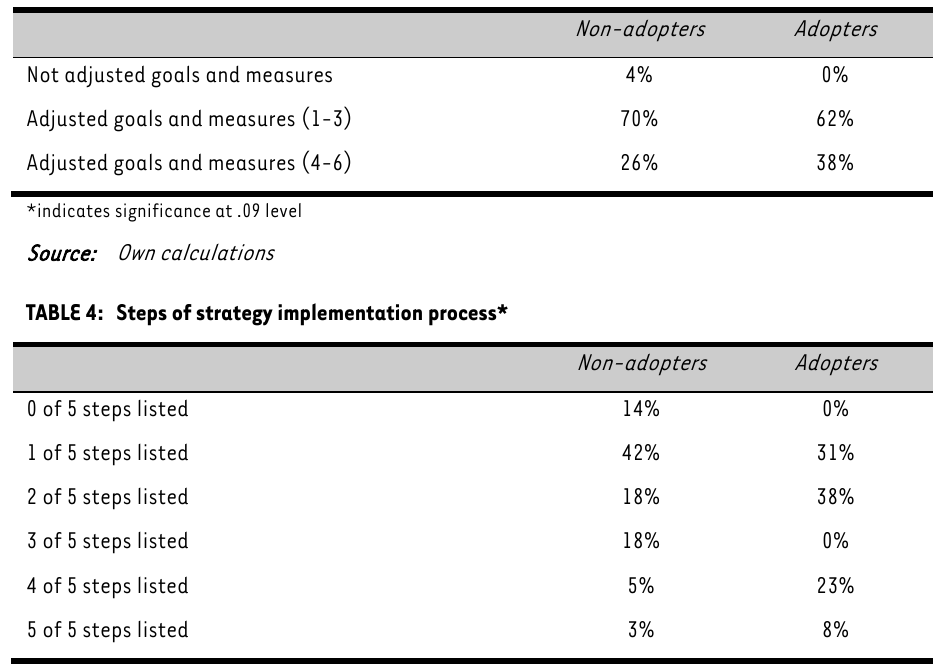
TABLE 3: Adjustment of goals and measures* Not adjusted goals and measures 4%